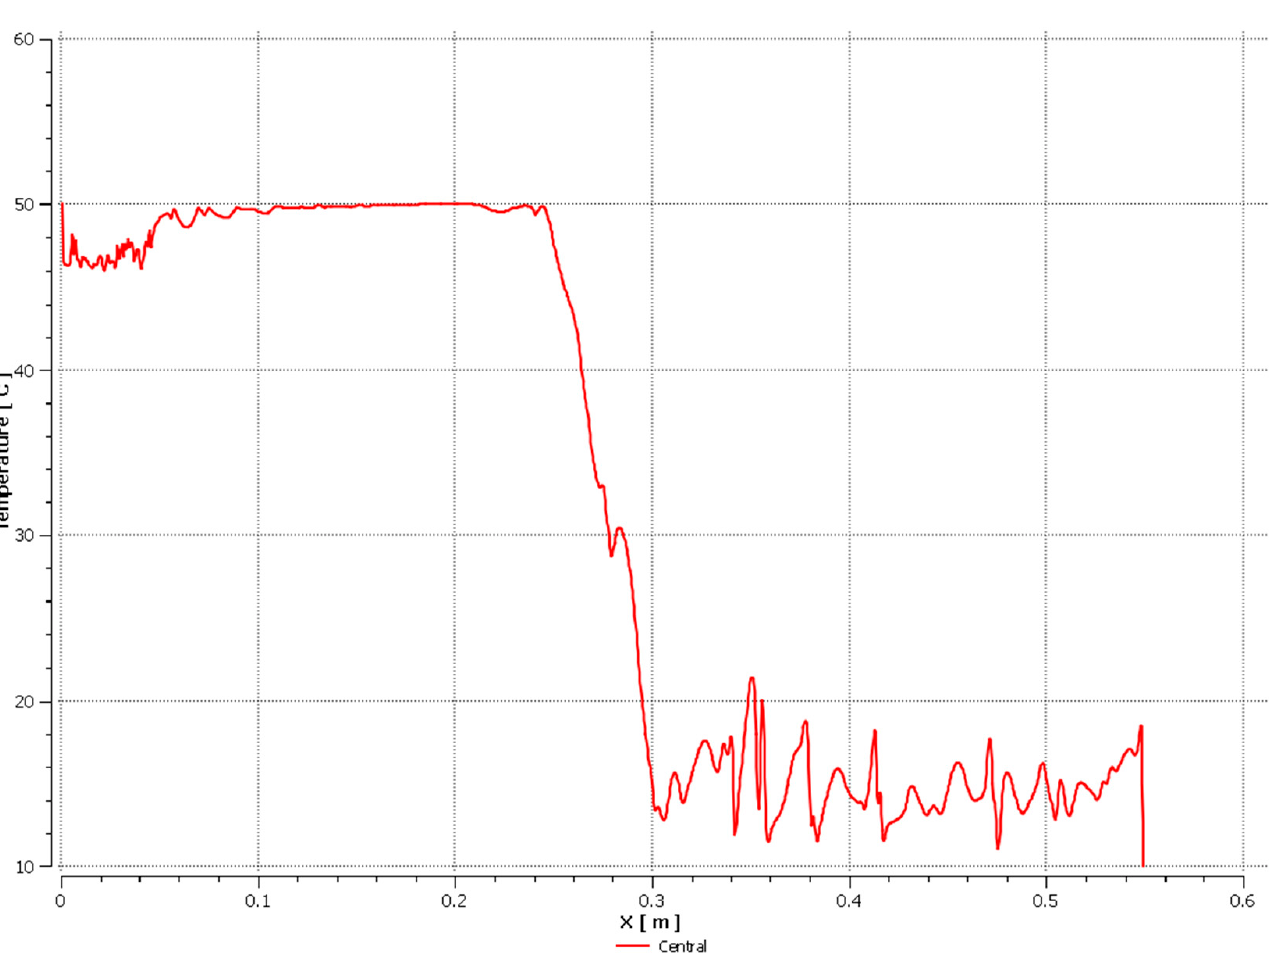
Figure 26. Temperature distribution along the height of the heat pipe’s wall.